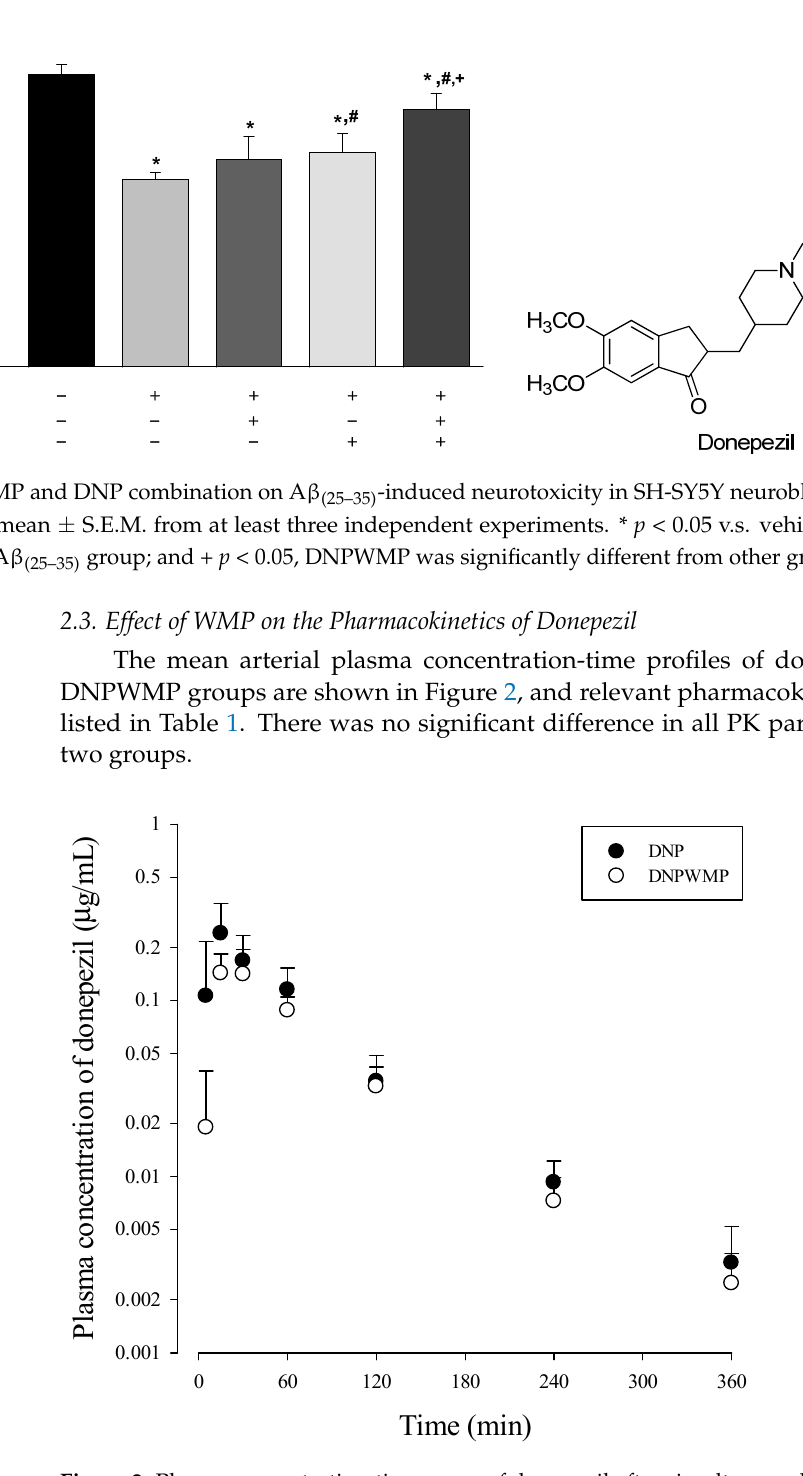
Figure 1. Effect of WMP and DNP combination on A β (25–35) -induced neurotoxicity in SH-SY5Y neu- roblastoma cells. Each value represents the mean ± S.E.M. from at least three independent experi- ments. * p < 0.05 v.s. vehicle-treated control group; # p < 0.05, vs. A β (25–35) group; and + p < 0.05, DNPWMP was significantly different from other groups, respectively.